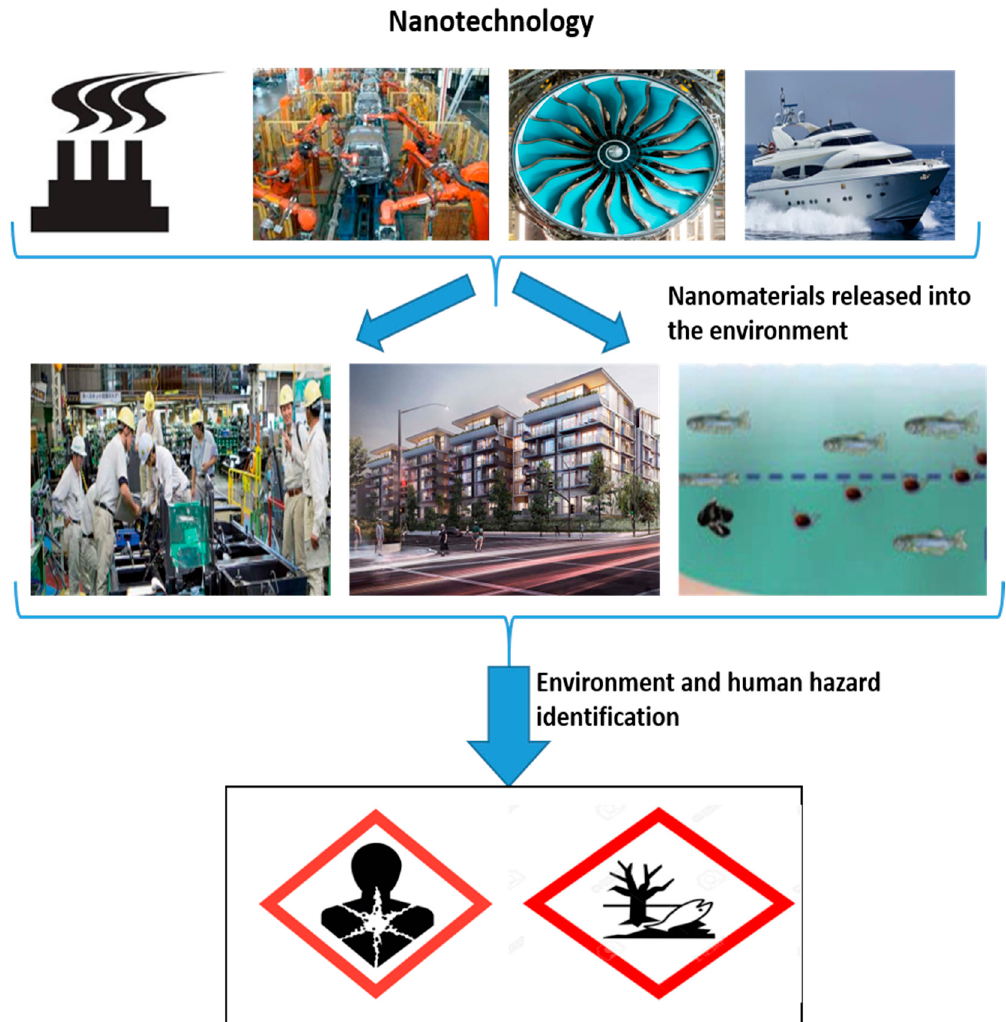
Figure 14. Nanotechnology environmental health and safety concerns.